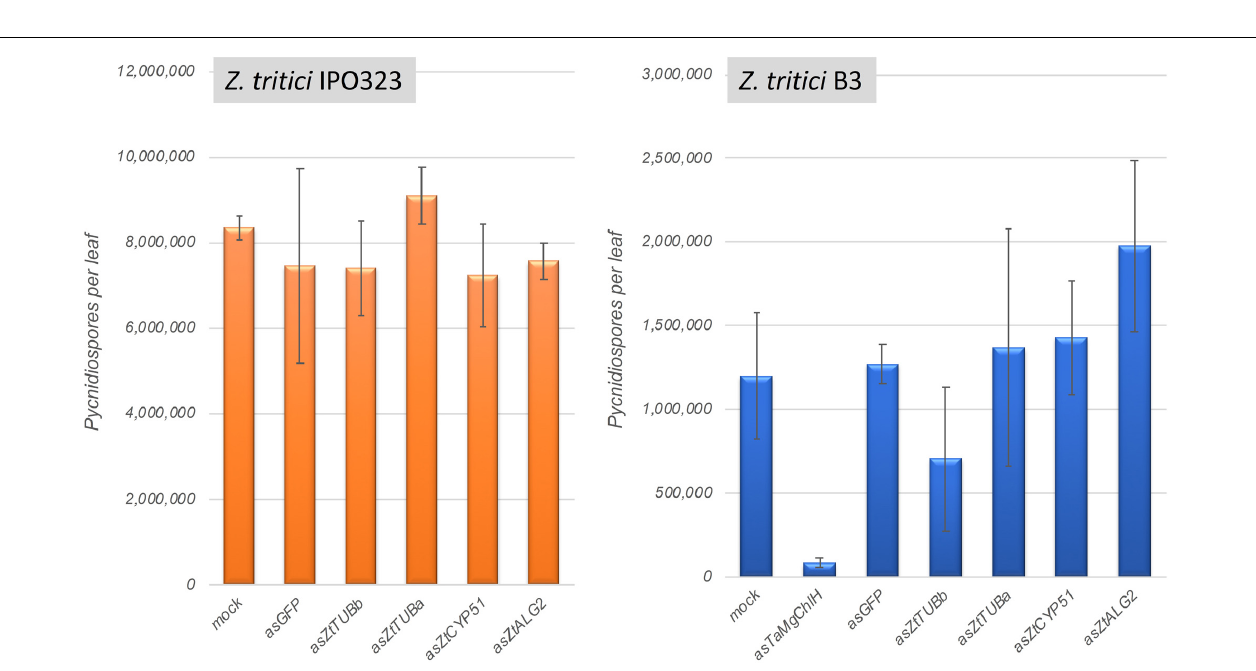
Frontiers in Plant Science |